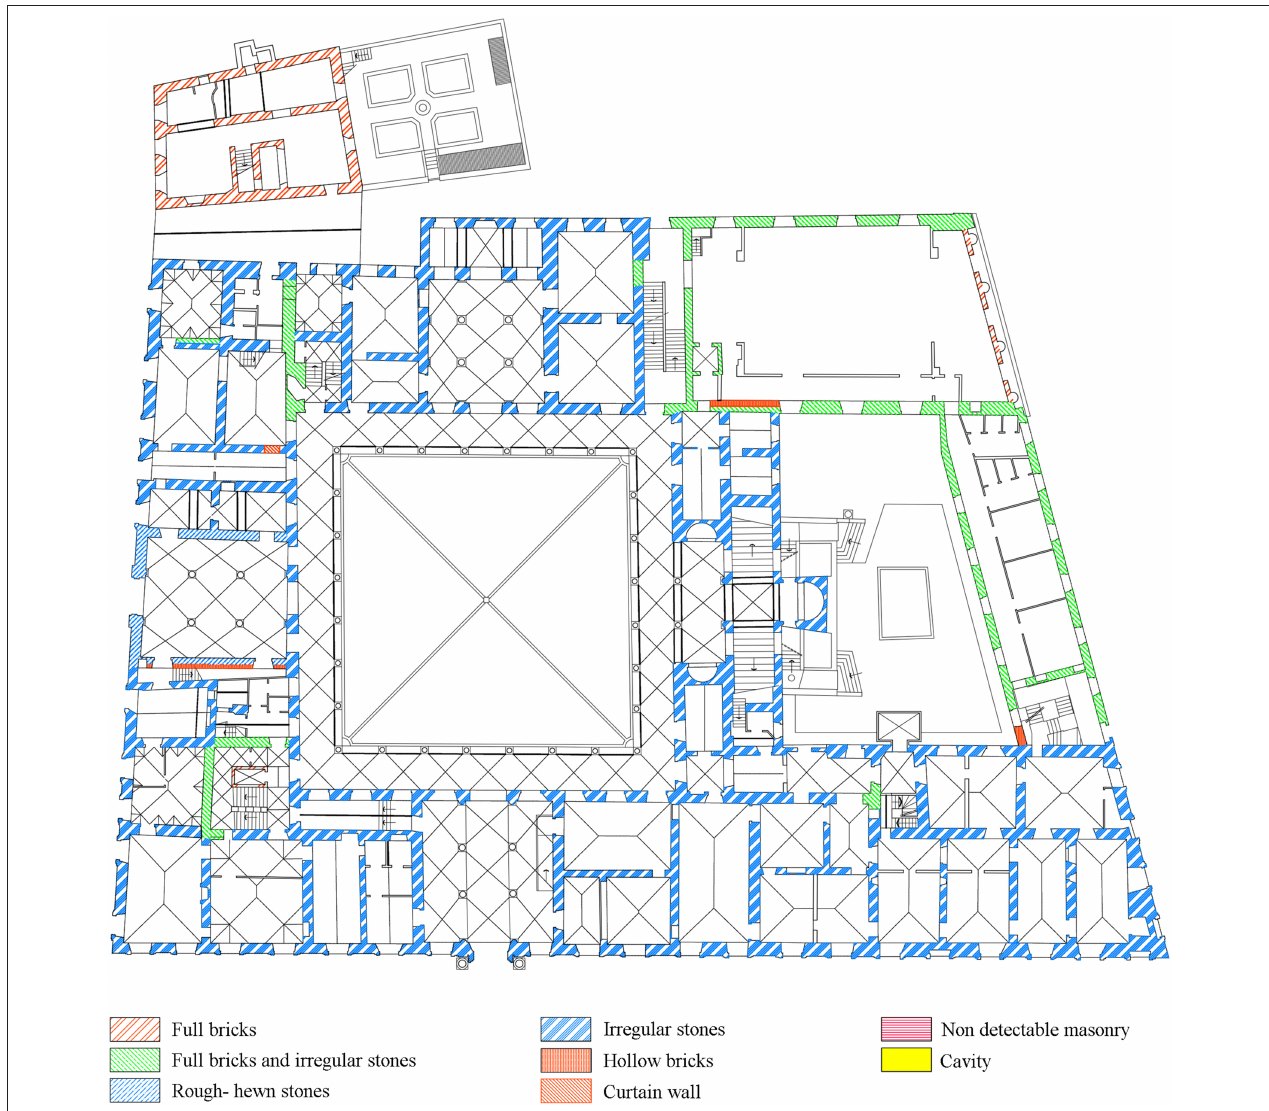
FIGURE 10 | Masonry typologies surveyed in Palazzo